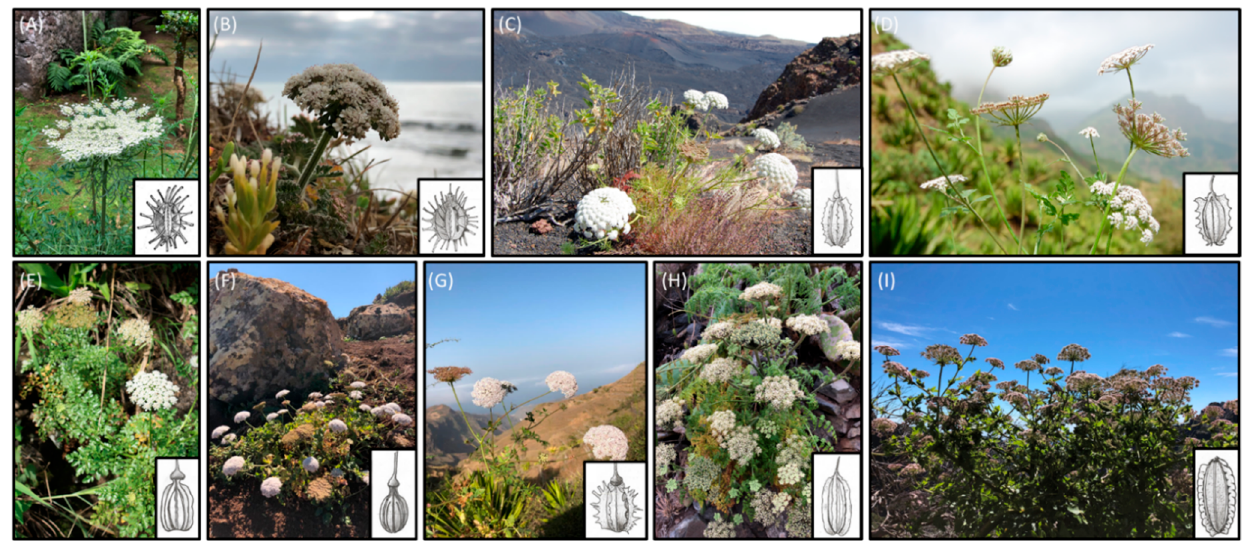
Figure 1. Daucinae subtribe endemic species from Macaronesia and mainland Portugal. Drawings of the fruits of each taxon are displayed. ( A ) Daucus carota subsp. azoricus ; ( B ) Daucus carota subsp. halophilus ; ( C ) Tornabenea tenuissima ; ( D ) Tornabenea annua ; ( E ) Tornabenea ribeirensis ; ( F ) Tornabenea bischoffii ; ( G ) Tornabenea insularis ; ( H ) Monizia edulis ; and ( I ) Melanoselinum decipiens .